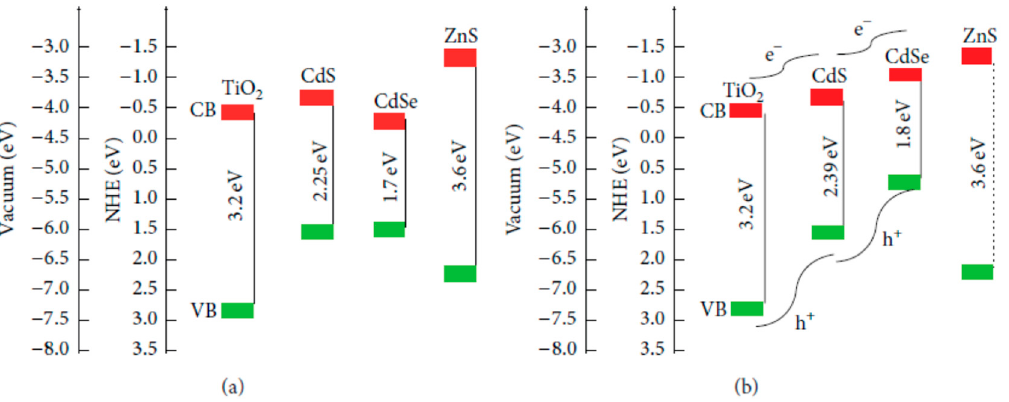
Figure 6. Schematic diagram of the energy level of a photoanode with ( a ) CdS CdSe in bulk scale and ( b ) CdS CdSe in the nanoscale from Grätzel, 2001 [114].